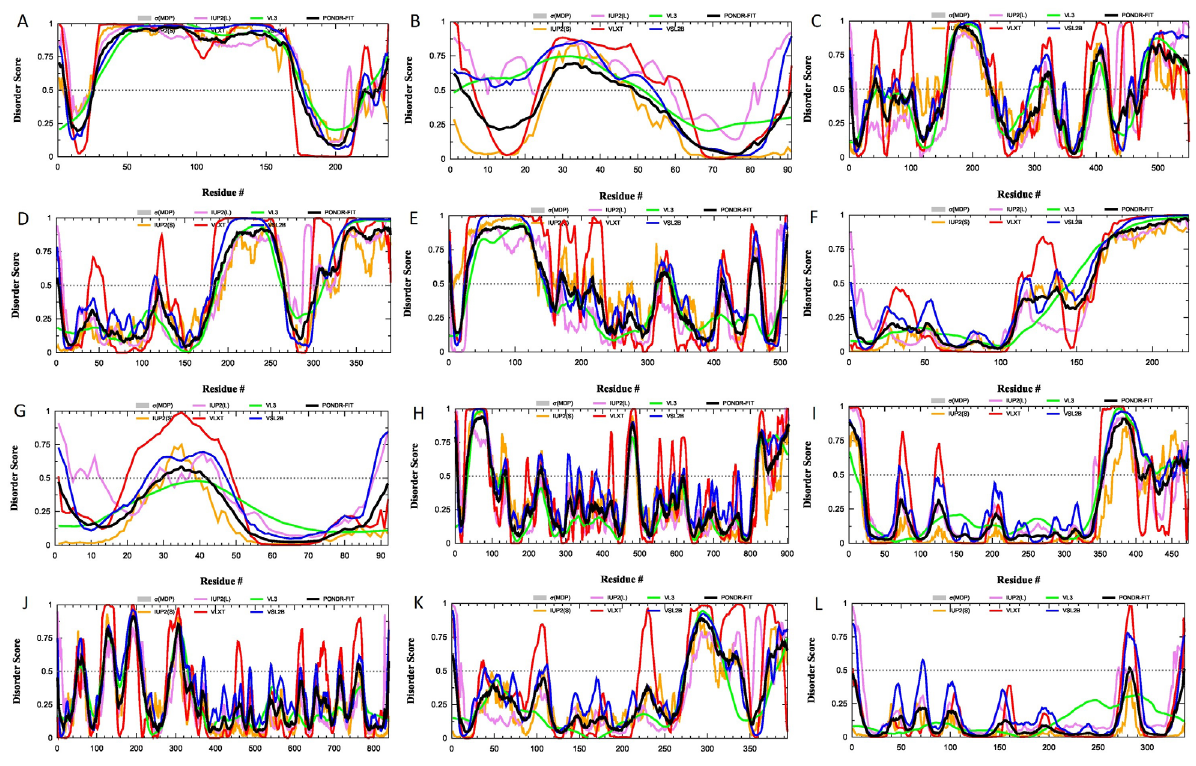
Figure 4. Intrinsic disorder status of 12 surface glycoproteins from HSV-1. Per-residue disorder profiles of the individual glycoproteins from HSV-1: (A) gG (UniProt ID: P06484); (B) gN (UniProt ID: O09800); (C) gE (UniProt ID: P04488); (D) gI (UniProt ID: P06487); (E) gC (UniProt ID: P10228); (F) gL (UniProt ID: P10185); (G) gJ (UniProt ID: P06480); (H) gB (UniProt ID: P10211); (I) gM (UniProt ID: P04288); (J) gH (UniProt ID: P06477); (K) gD (UniProt ID: Q69091); (L) gK (UniProt ID